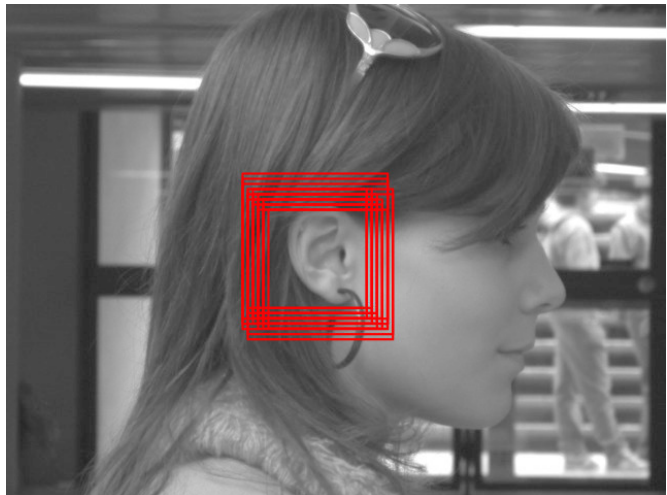
Figure 7. Sample of multiple overlapping detections casted as individual detection windows on an input image.